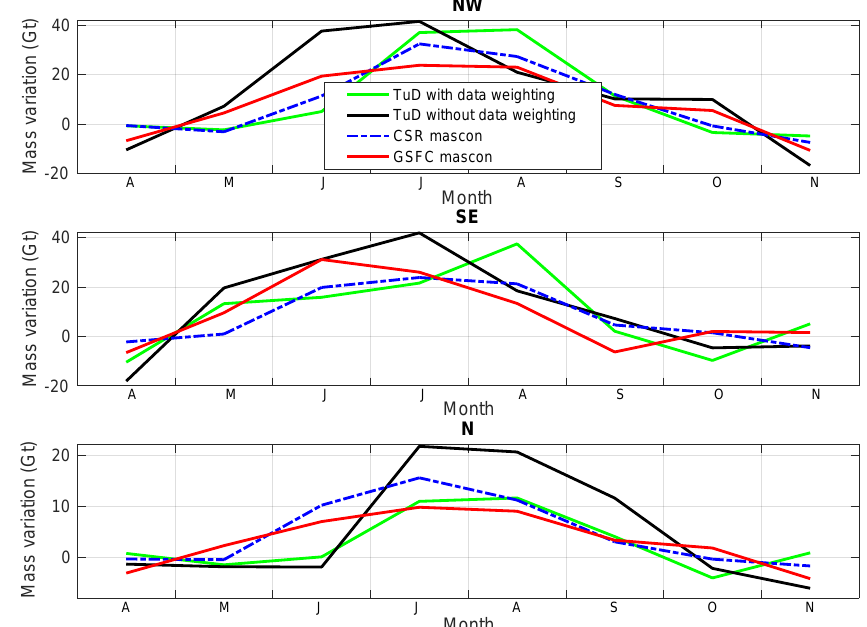
Figure 9. Similar to Fig. 6, but the estimates of seasonal meltwater storage are extracted from different mascon solutions for individual drainage systems: NW, SE, and N. The errors are not shown in the plot for the sake of its readability. The mean standard deviations of the errors for NW, SE, and N are 25, 26, and 9Gt, respectively.